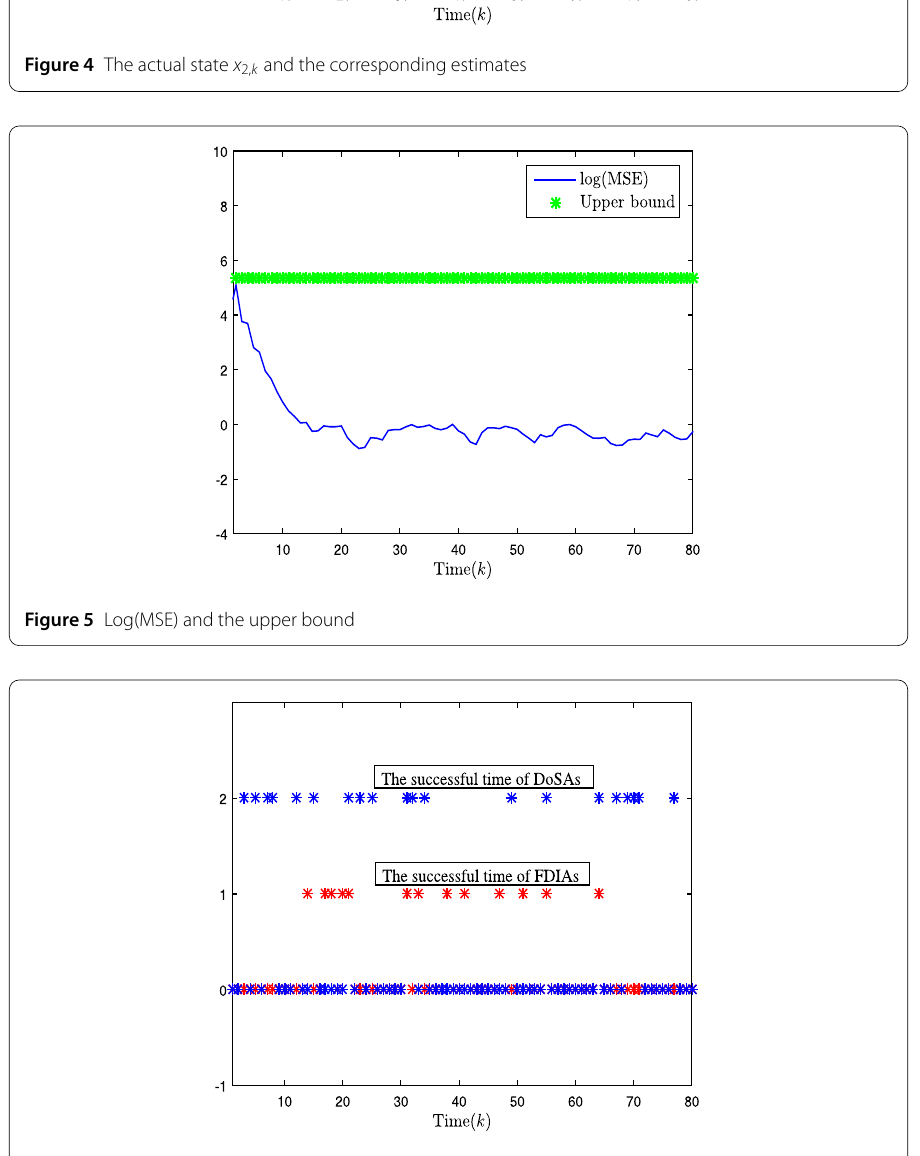
Figure 6 The successful attacks